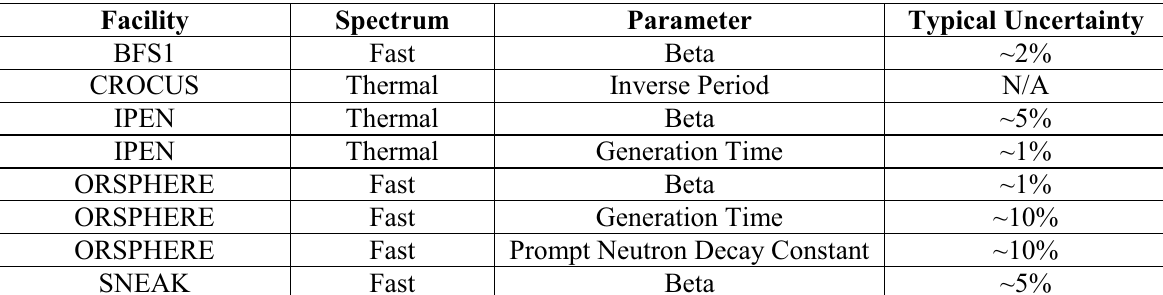
Table VI. Kinetics parameters experimental benchmarks in the IRPhEP Handbook Facility